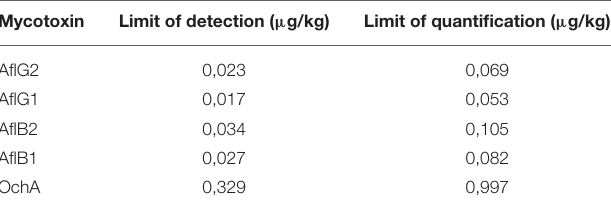
TABLE 5 | Limit of detection/Limit of quantification for AflB1, AflB2, AflG1, AflG2, and OchA. Mycotoxin Limit of detection ( µ